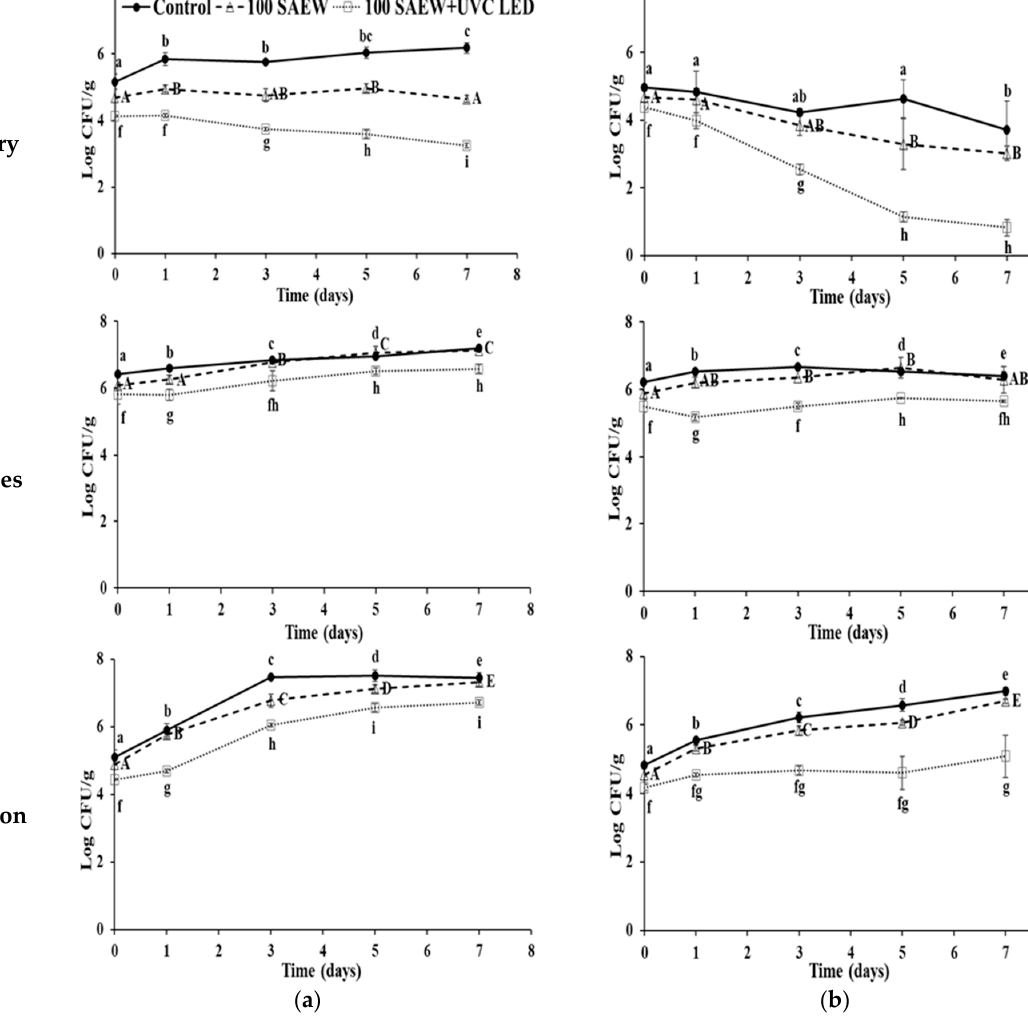
Figure 3. Log number of enterohemorrhagic E. coli (EHEC) ( a ) and S. aureus ( b ) after treatment in strawberry, baby leaves, and sliced onion stored for 7 days at 15 °C. ● , no extra wash with sanitizer (control); △ , aerosolization with 100 ppm SAEW (100 SAEW); □ , aerosolization with 100 ppm SAEW and UVC LED irradiation with 275 nm (100 SAEW + UVC LED). a–e; A–E; f–i Different letters within each treatment represent significant differences by Duncan’s multiple tests at p < 0.05.